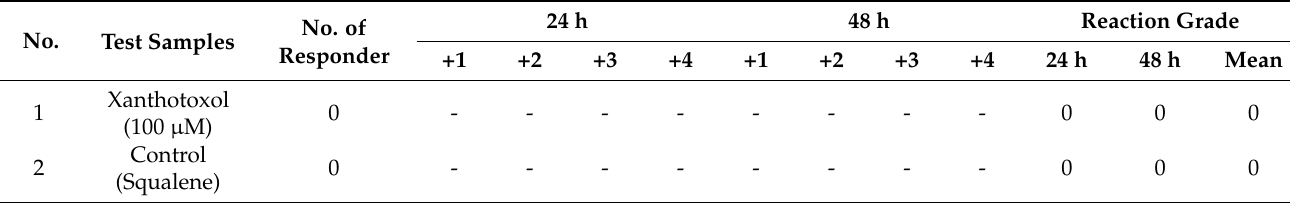
Table 1. Results of human skin primary irritation test ( n =